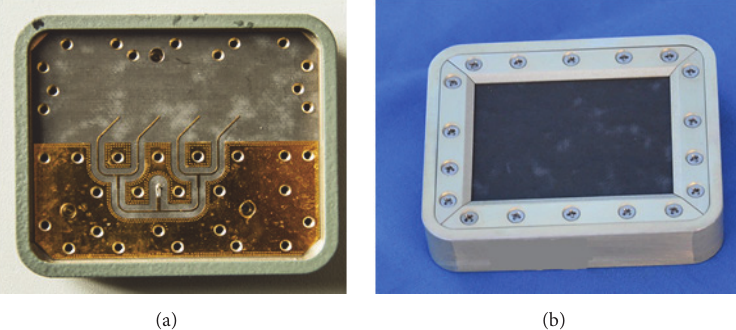
Figure 6: Photograph of the fabricated IMF-CBSA array. (a) The unassembled product; (b) the final product.